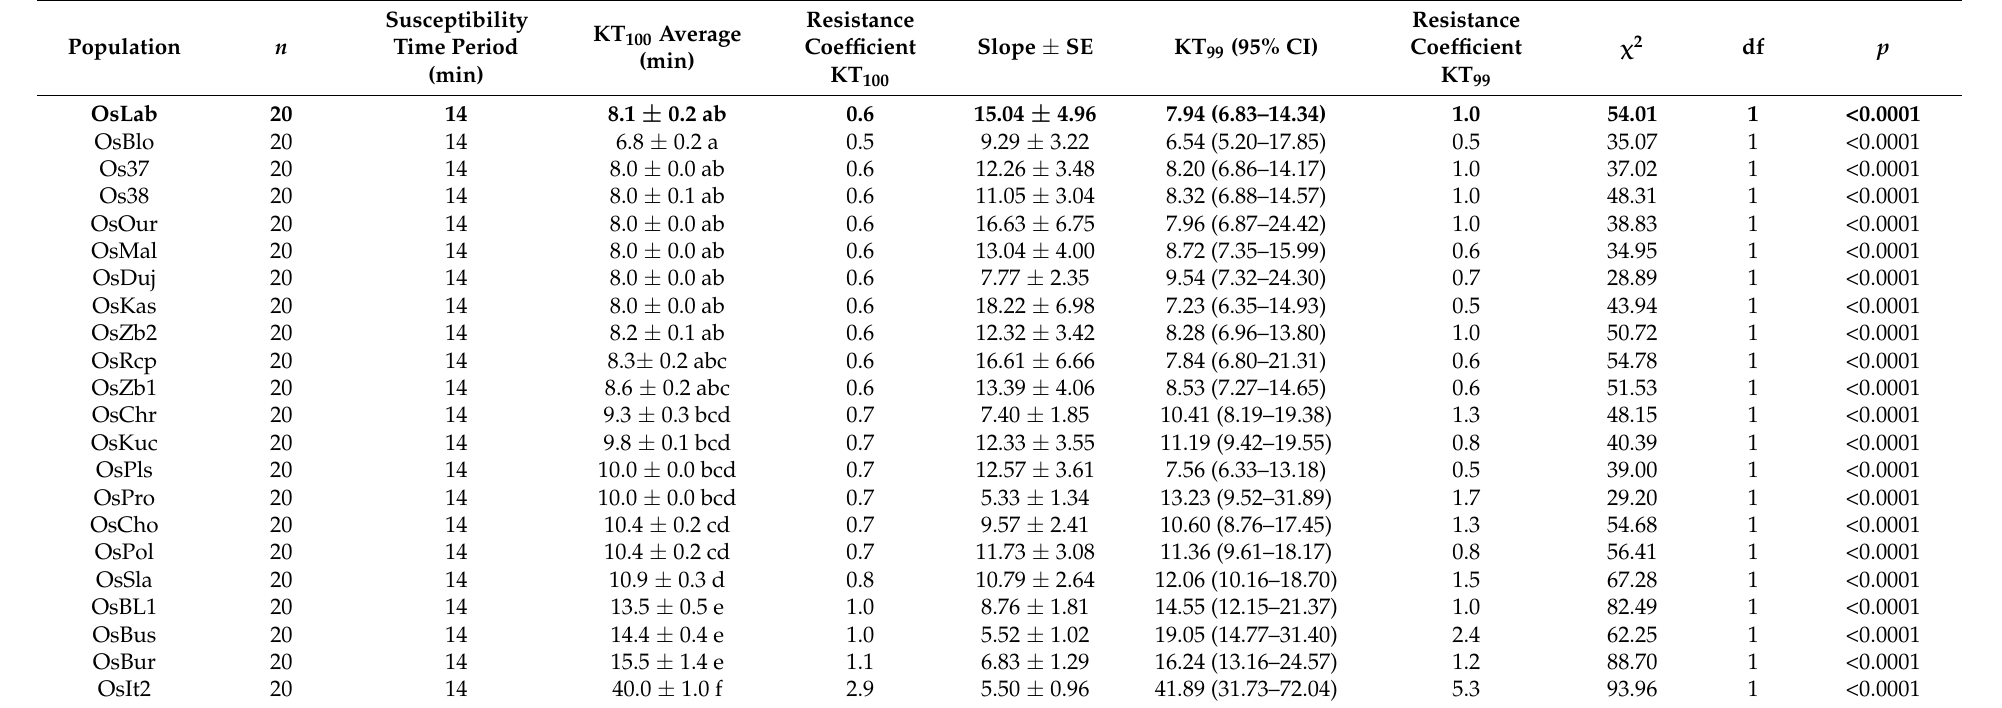
Table 2. Sensitivity or resistance level of 22 populations of Oryzaephilus surinamensis to phosphine based on the knockdown rapid test (PTT–Degesch, Gemany) from the Czech grain stores and the statistical comparison among the tested populations (21 field populations and 1 reference laboratory OsLab population). (Different letters (a–f) indicate statistically significant differences; n = numbers; p = p